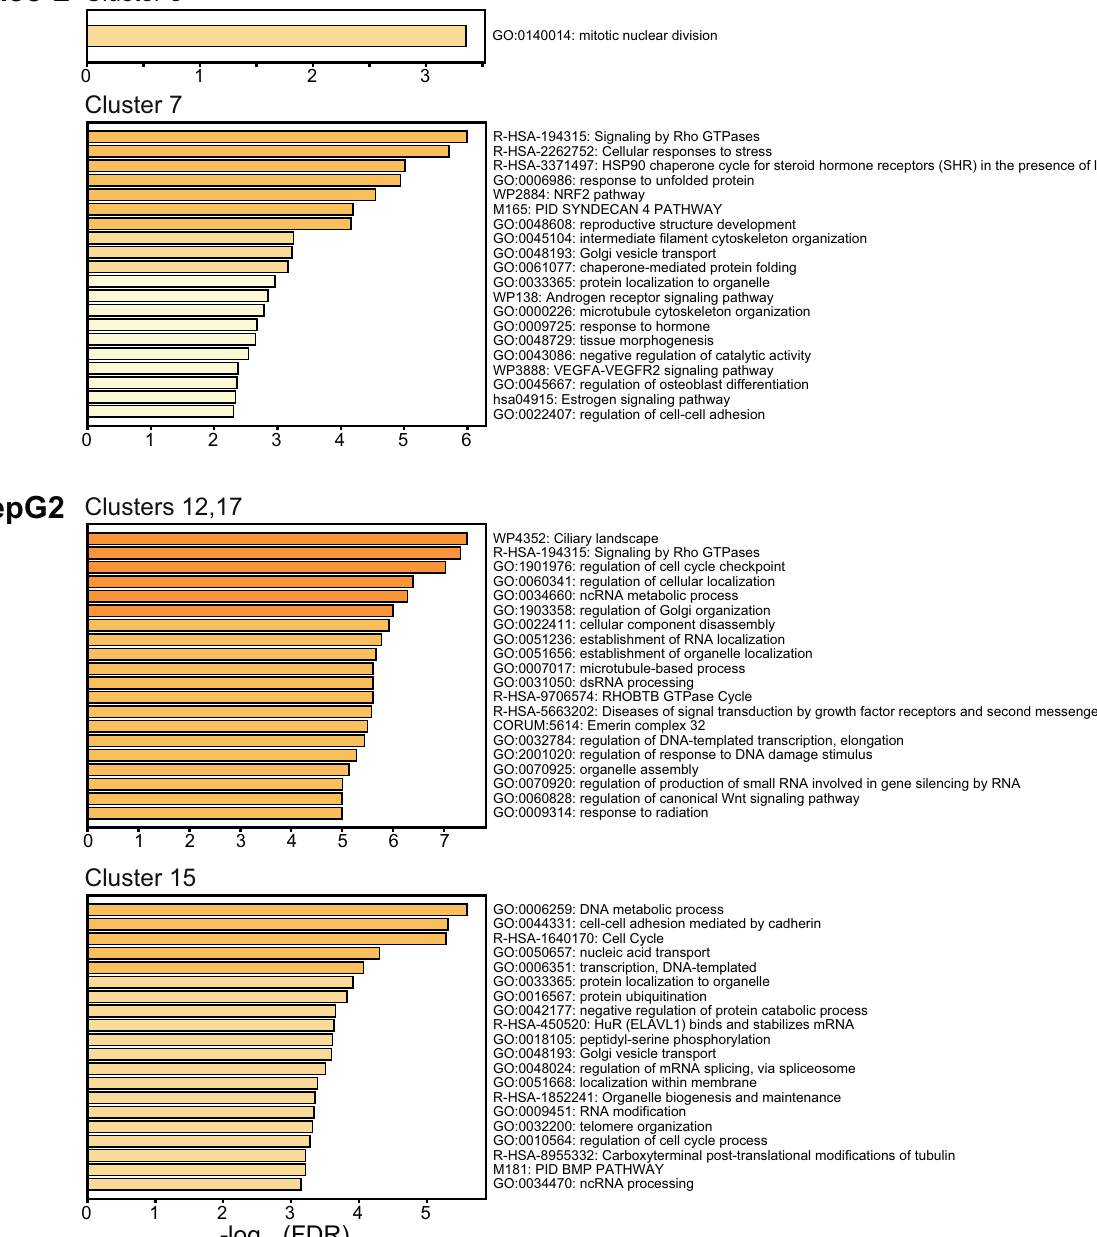
cells, HepG2 cells transformed from differentiated liver cells to proliferating cells. Cell cycles and cell division are essential to maintain tissue homeostasis, but in diseases such as NAFLD, they often highlight the imbalance of the cell cycle caused by disrupted metabolic signaling 47 . Overall, the results with our platform indicate that HepG2 cells co-cultured with Caco-2 cells were activated towards NAFLD-like gene expression networks with FFAs treatment.